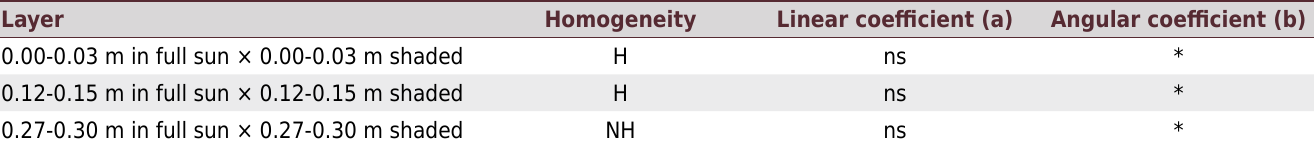
H and NH correspond to the homogeneity or non-homogeneity of the data and * and ns correspond to significant or non-significant, at 5 % probability, according to Snedecor and Cochran (1989).